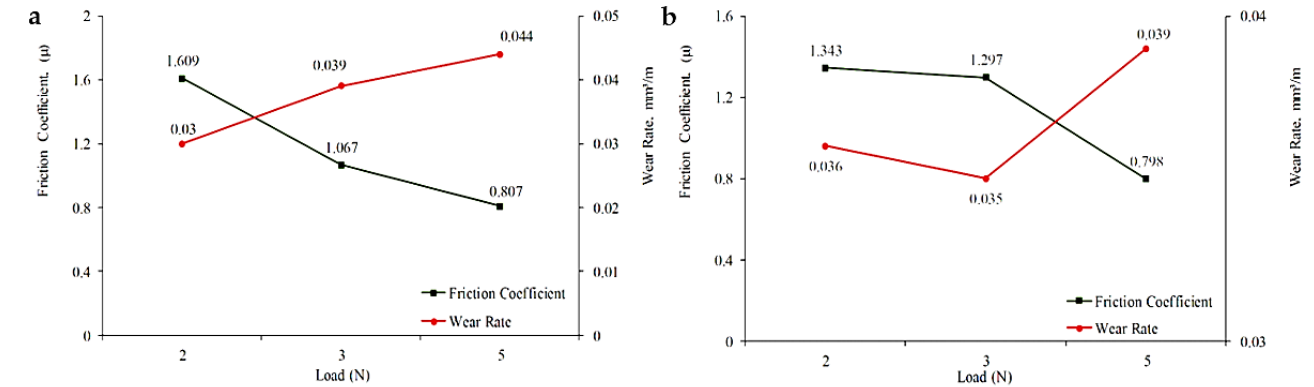
Figure 7. Friction coefficient and wear rate at 2, 3, and 5 N loads of Al coatings using ( a ) HPCS and ( b ) LPCS.